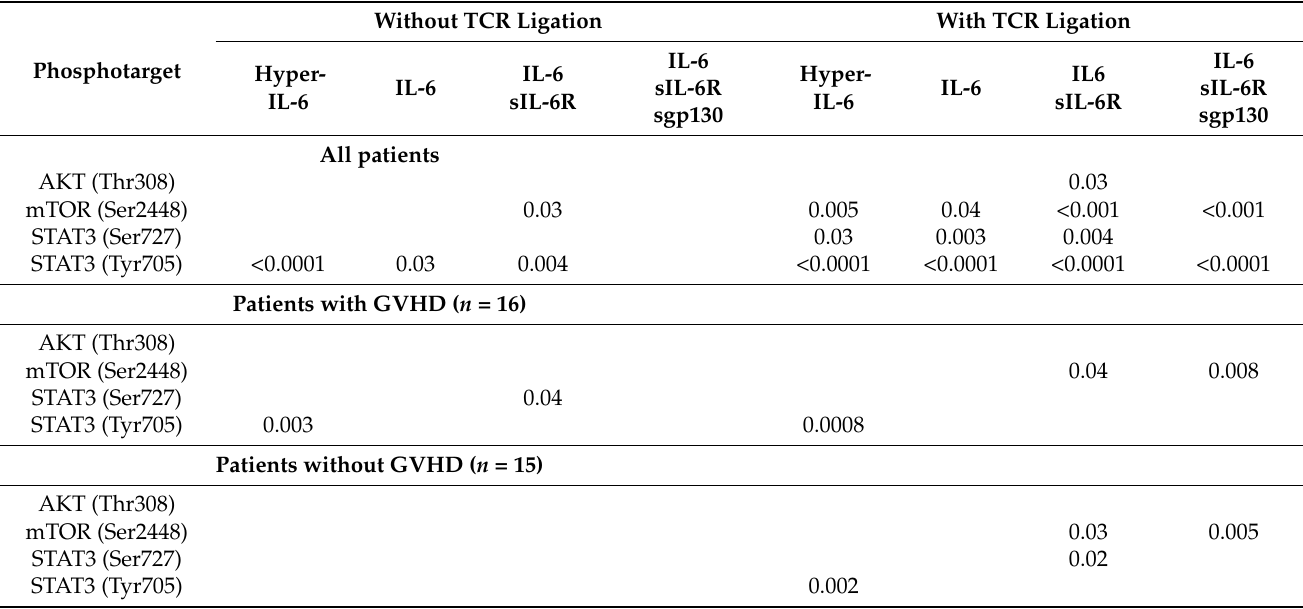
Table 4. The effects of four different forms of IL-6 stimulation on circulating CD3 + CD8 + T cells. We investigated effects on the phosphorylation of the intracellular mediators STAT3/Akt/mTOR. IL-6 stimulation was tested alone and in the presence of the activation signal anti-CD3 + anti-CD28. The table presents the statistically significant increases, i.e., p -values < 0.05. The T cells were derived from the peripheral blood of allotransplant recipients with and without previous acute GVHD on day +90 post-transplant. All comparisons were carried out using the Wilcoxon signed-rank